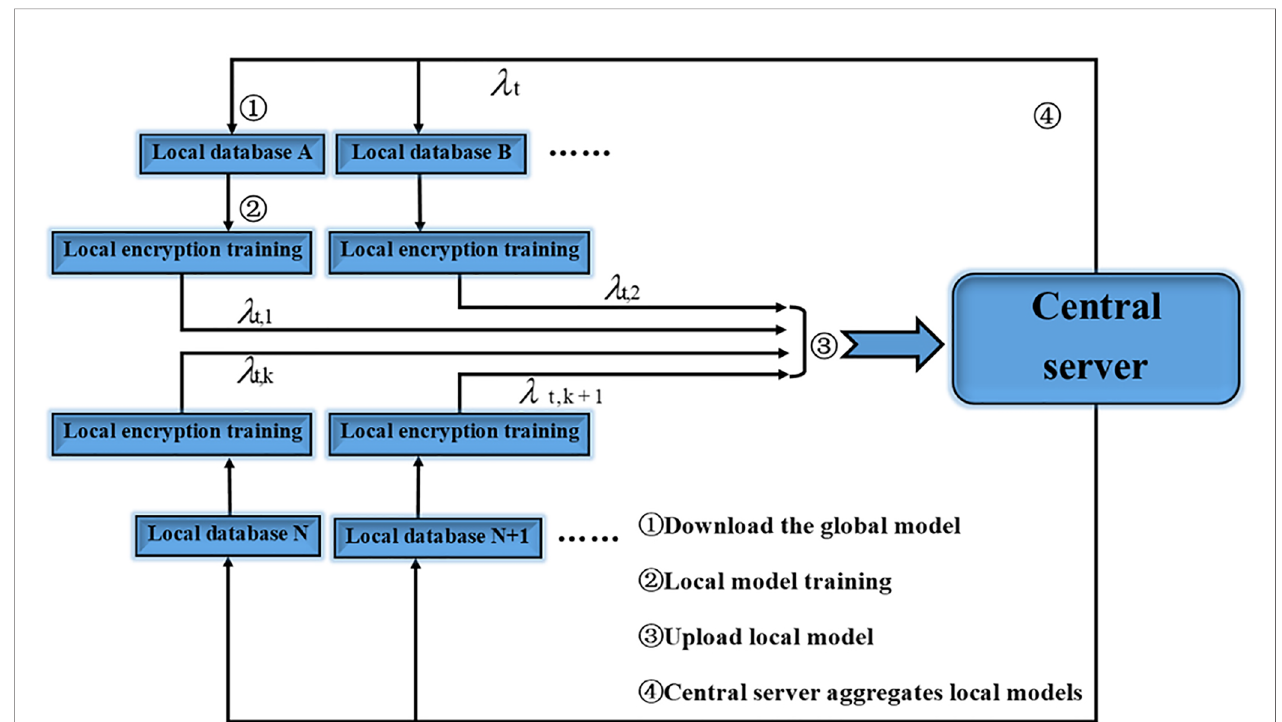
FIGURE 1 | Federated learning work fl